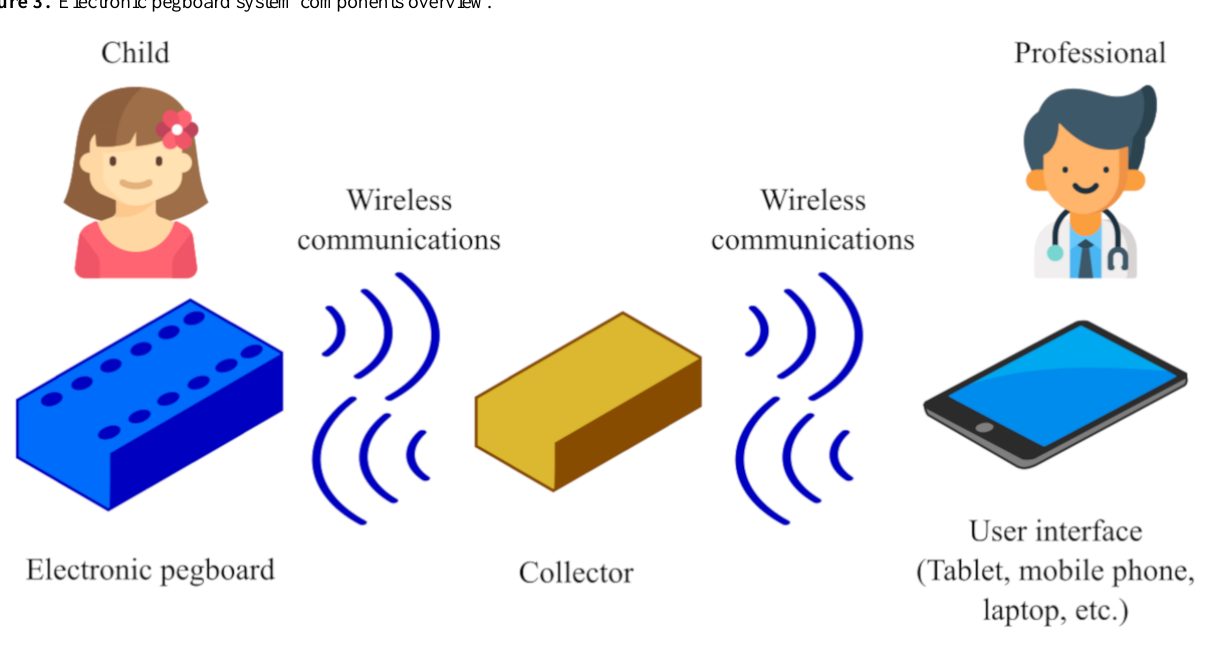
Figure 3. Electronic pegboard system components